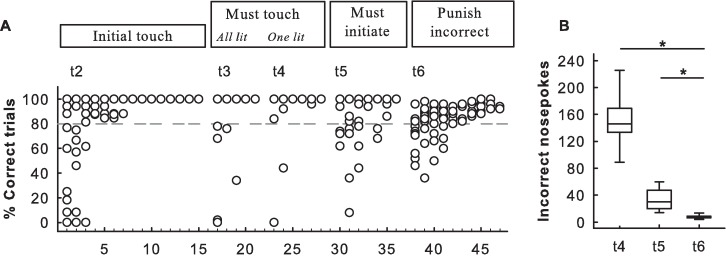
Automated touchscreen training.(A) Percentage of individual correct trials across Training phases 2 (t2) to 6 (t6). White circles show individual performance during a session. Circles can overlap. In t2, the percentage of correct trials is also referred to as the percentage of active trials (see Methods). Difficulty increases from t4 to t5 when rats learn to self-initiate a trial by poking into the pellet magazine. In t6, incorrect trials are punished with a time out. Data are based on n = 12 individuals. Due to technical problems, six rats continued with t2 for a further eight sessions although they already had achieved > 80% correct trials (grey dotted line; n = 12 sessions 1–5 and n = 6 sessions 8–15). (B) The number of incorrect nose pokes (nose pokes to unlit windows) during the final three phases of training. Boxplots show median, quartiles and 10th/90th percentiles. *p < 0.05 between t4 and t6, and t5 and t6